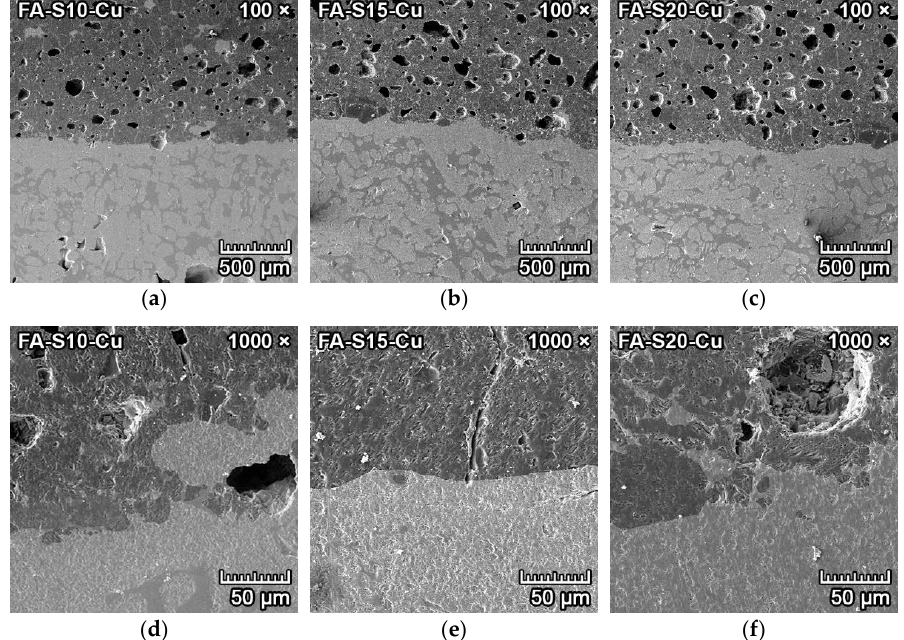
Figure 12. SEM microstructure of the transition zone between copper (light grey and smooth) and forsterite – spinel ceramics (darker and porous) of fly ash – based mixtures FA-S10, FA-S15 and FA-S20, with a magnification of 100× ( a – c ) and a magnification of 1000× ( d – f ).